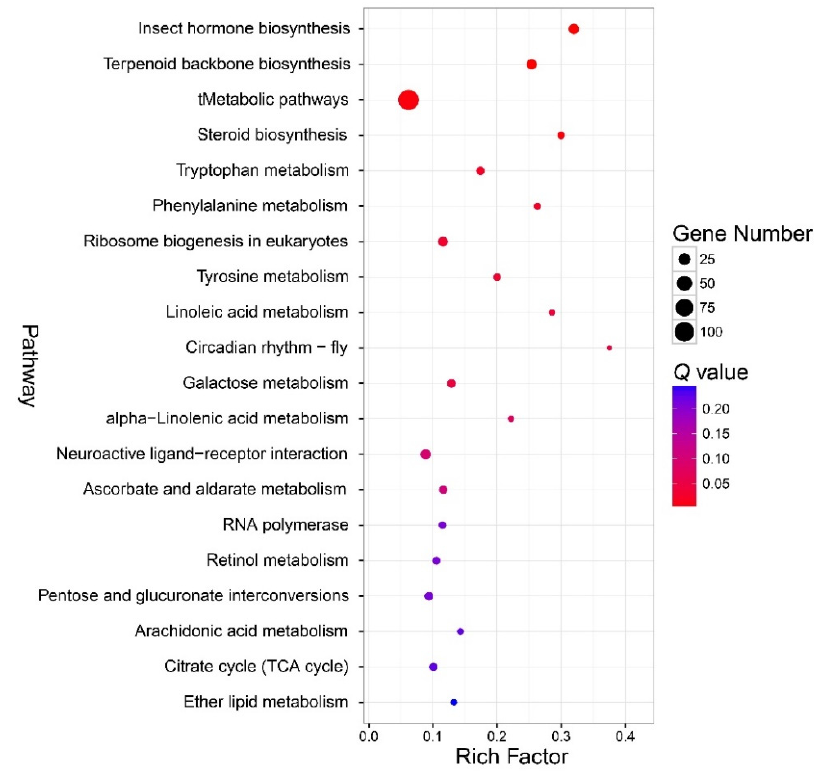
Figure 6. Bubble chart that shows the top 20 enriched pathways according to the Kyoto Encyclopedia of Genes and Genomes (KEGG) enrichment analysis. Note: the y-axis is the name of the pathway, the x-axis is the rich factor. Rich factor is the ratio of the number of the differentially expressed genes (DEGs) in a pathway to the number of total genes annotated to the pathway.